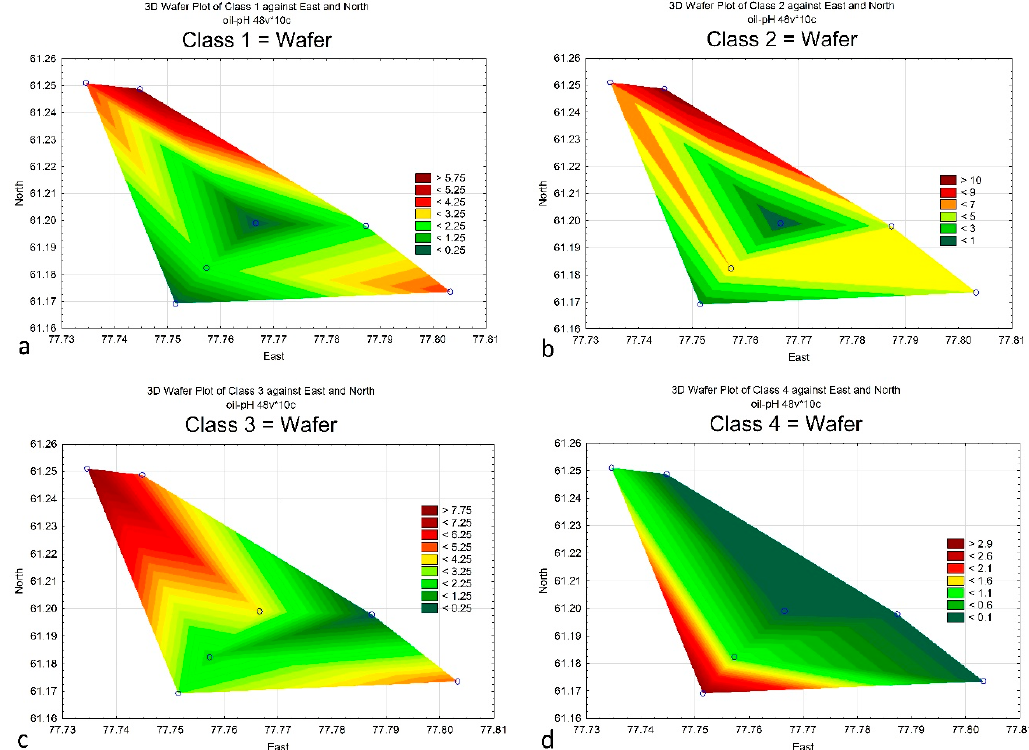
Figure 7. Distribution maps for indicators of Water Quality Class 1–4 ( a – d ) in seven studied sites of the